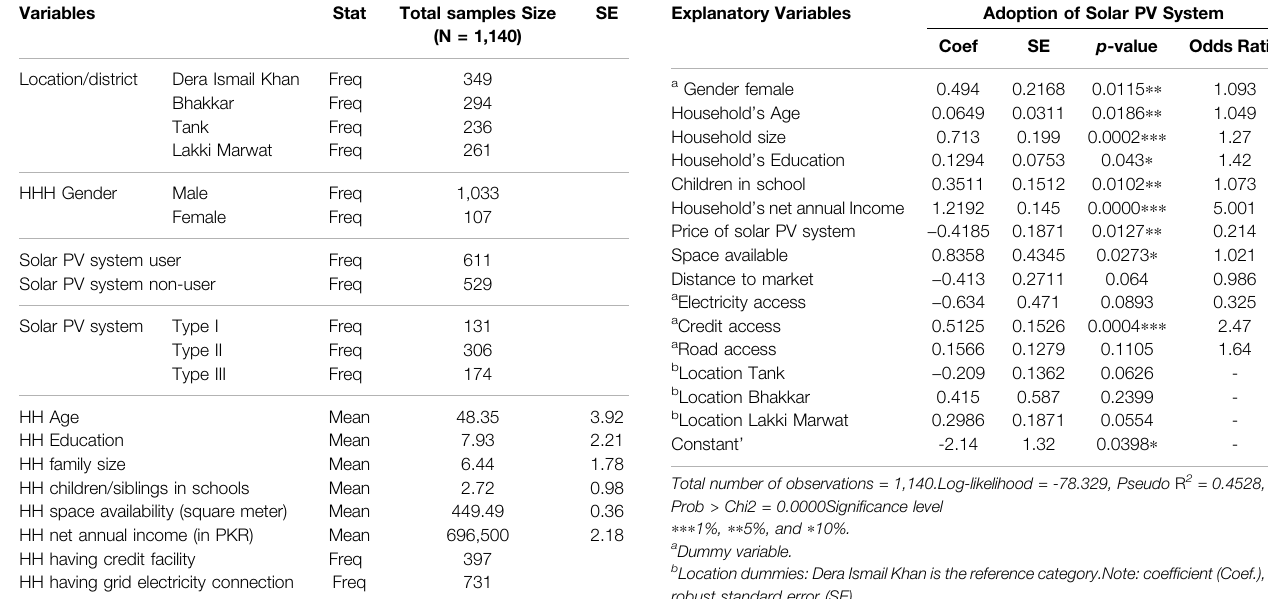
TABLE 3 | Descriptive statistics of household characteristics. Variables